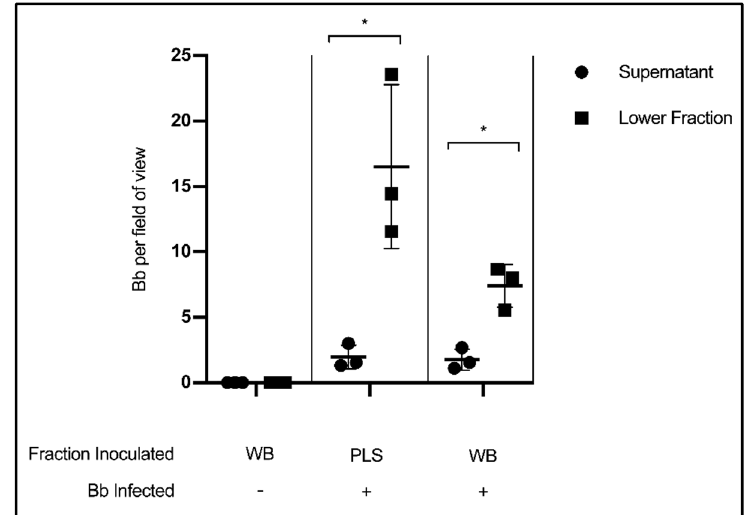
Figure 3. Stratification of Borrelia in blood following separation of cells and plasma. Quantification of Borrelia per field of view in the supernatant/liquid fraction and cellular/lower fraction following centrifugation at 400× g , 20 min. Data presented as the means with standard deviation. Asterisks (* = p < 0.05) indicate significance difference using one-tailed paired t-tests ( n = 3).